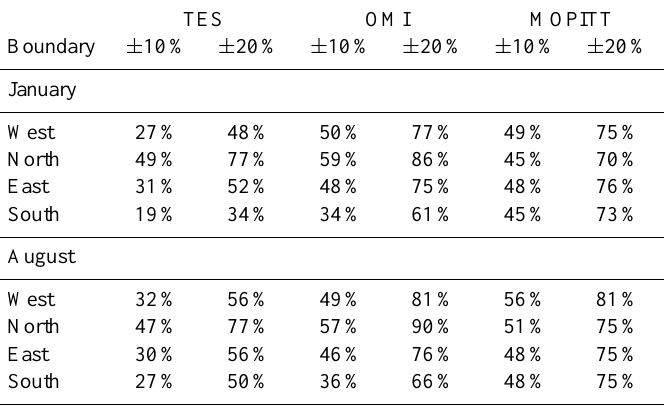
Fig. 5. Individual retrieval relative bias shown as boxplots for each altitude bin in each satellite product (TES, OMI, and MOP=MOPITT). Whiskers indicate min/max, the box represents the interquartile range, the blue line in the box is the median and the red cross is the mean. Vertical grey lines delineate the ± 10% (fine) and ± 20% (heavy) bias ranges. Table 2. Percentage of retrieval values below 50hPa that are within 10 and 20 percent of TES, OMI, and MOPITT for each boundary face (West, North, East, and South) from 2006 to